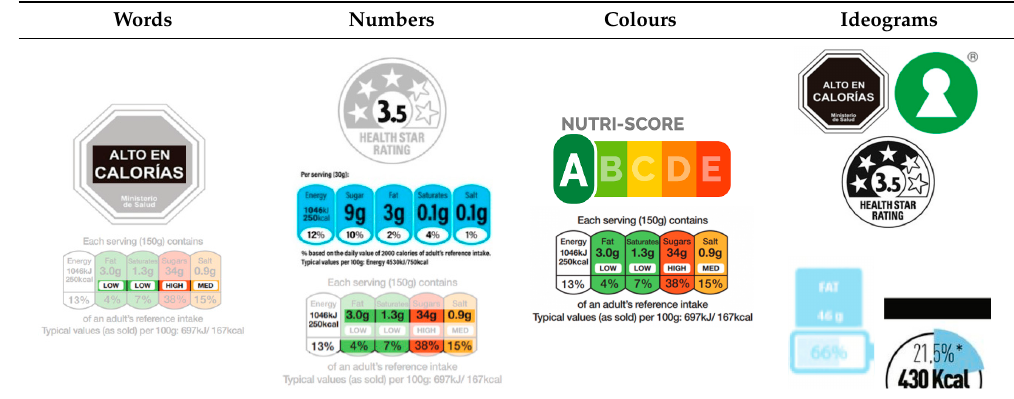
Table 4. Description and examples of Signs used in existing FoPLs.